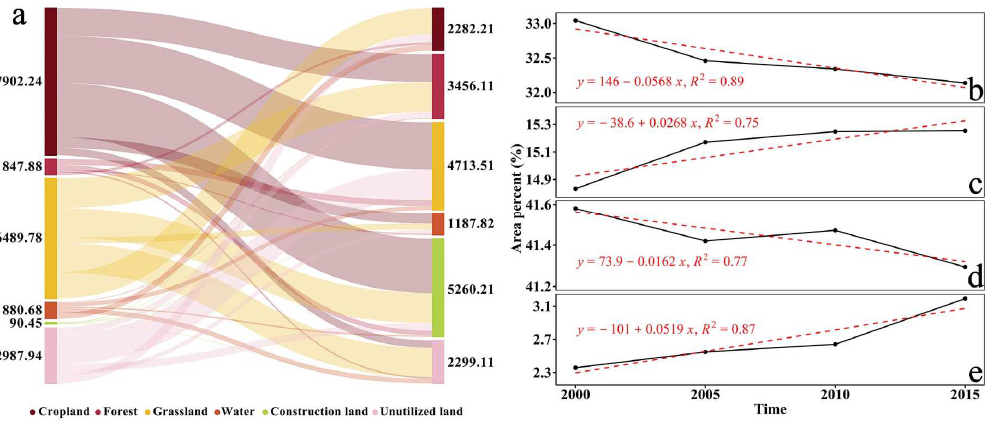
Figure 10. Land-use change of the LP in ABP: ( a ) Land use transition among different land types, and changes of ( b ) croplands, ( c ) forests, ( d ) grasslands, and ( e ) construction land.